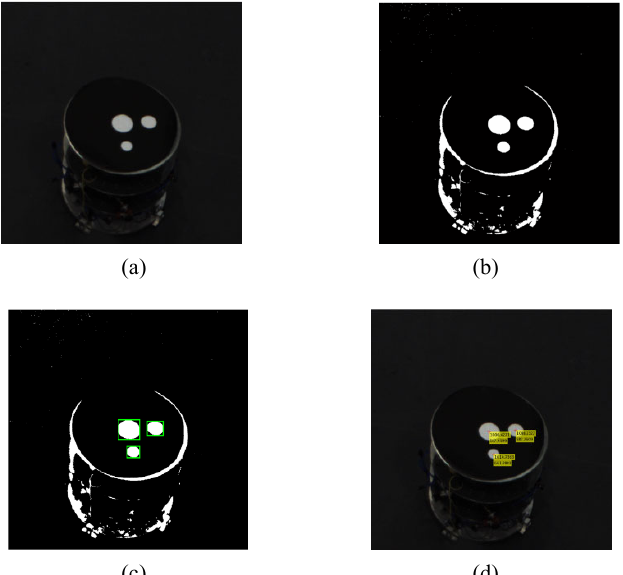
Table 2. The maximum errors for the center and the angle are 0.036 pixels and 0.059 ˚ , respectively.